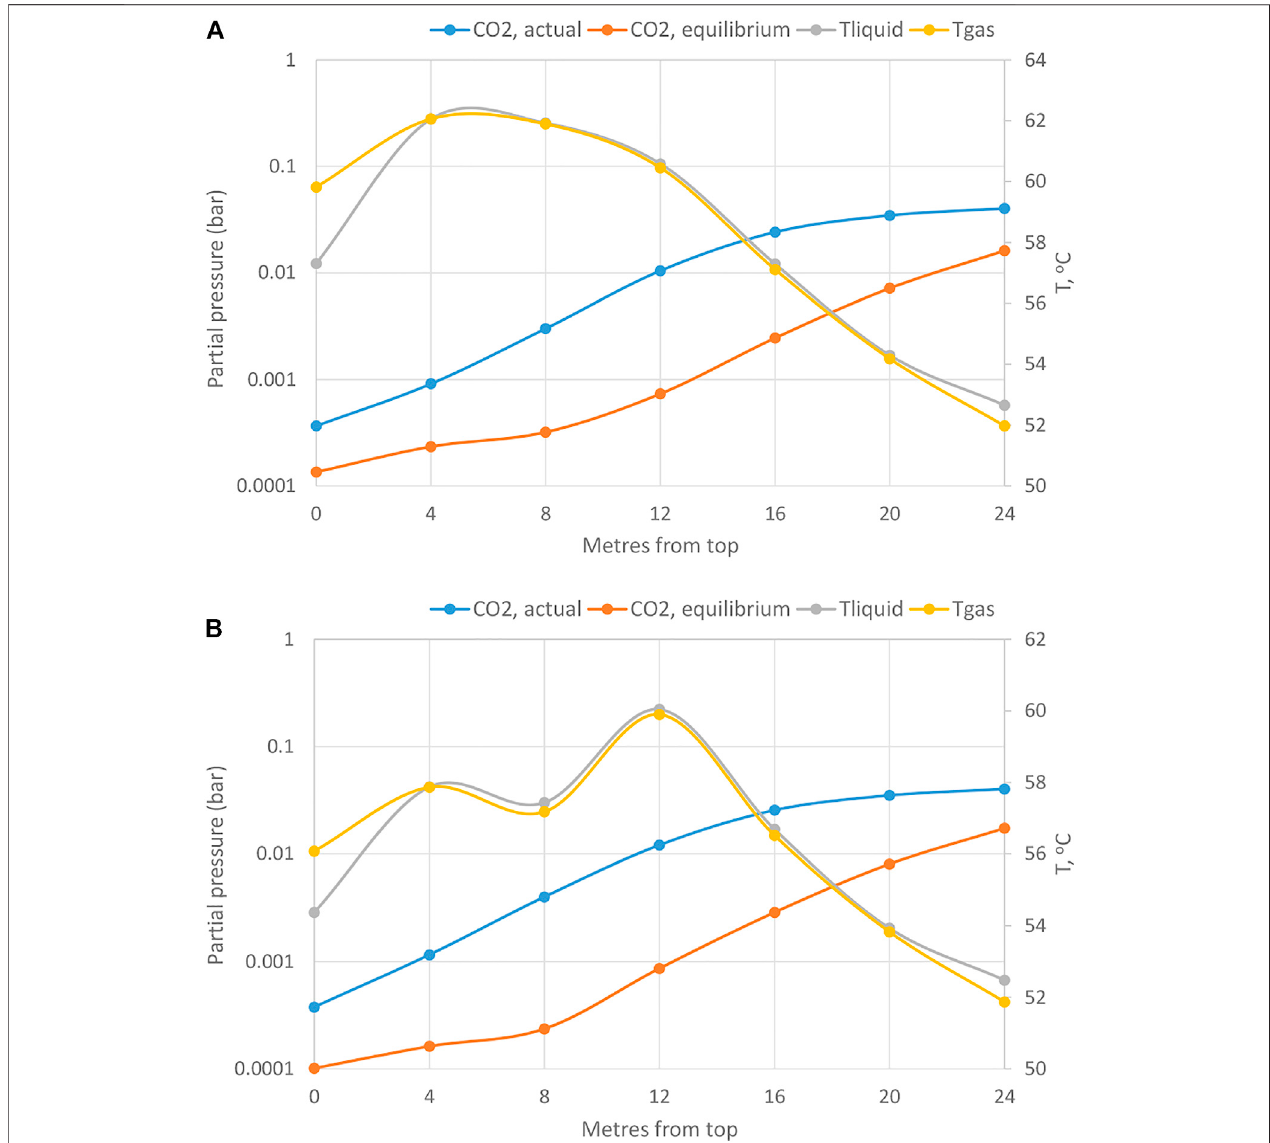
FIGURE 10 | Actual and equilibrium CO 2 partial pressures and temperature pro fi les along the absorber for 24 m packing height, capture level of 99% and lean loading of 0.12 molCO 2 /molMEA [ (A) with no intercooling, (B) with intercooling temperature = 35 °